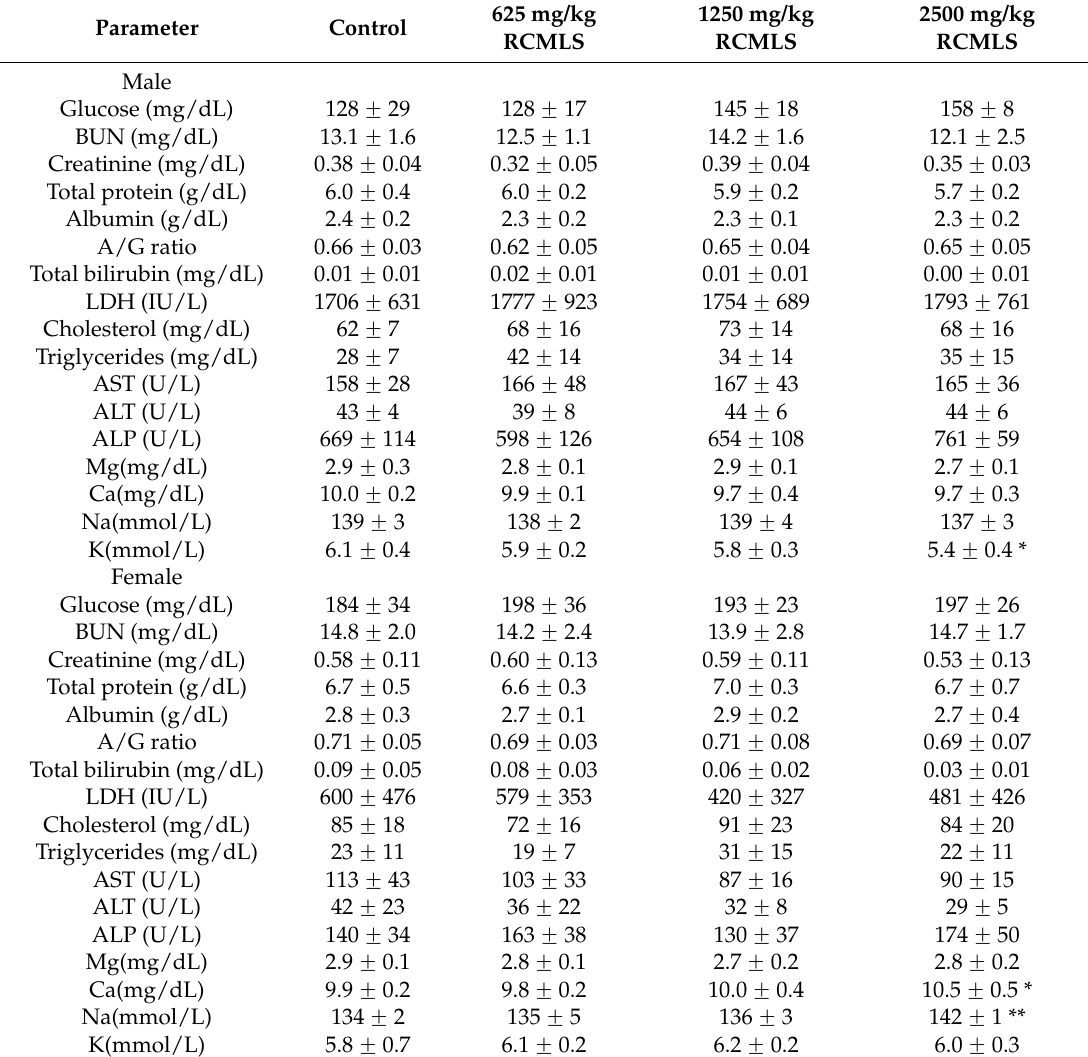
Table 7. Serum biochemistry in 14 days repeated oral dose toxicity study of the leaves and stems of Rubus coreanus